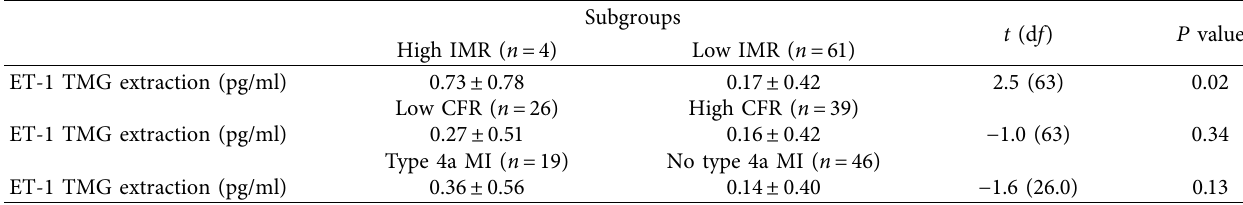
Table 2: Subgroup analysis.